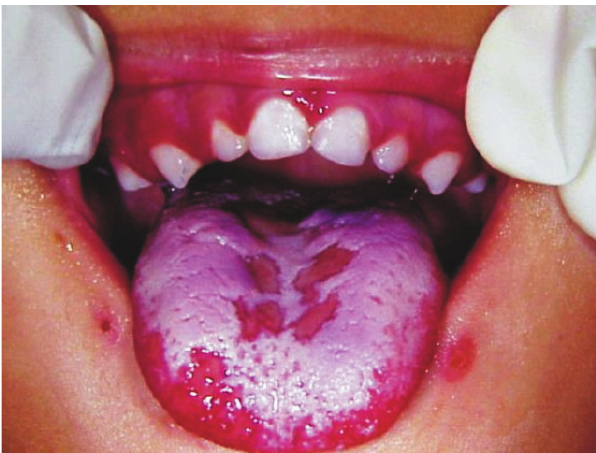
Figure 2 - Primary infection of HSV-1 affecting the gingival, tongue and skin